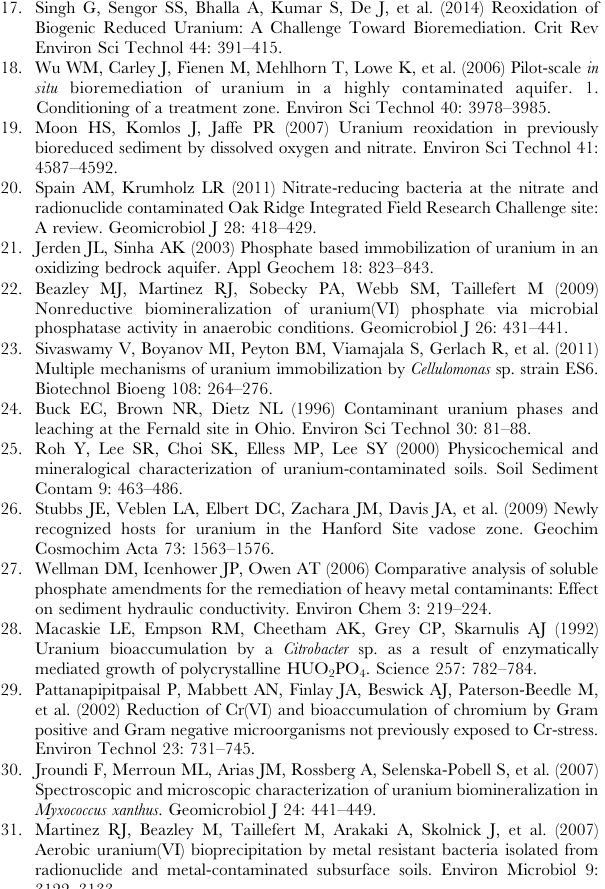
Figure S1 Venn diagram of OTUs enriched in multiple treatments. (A) Archaeal and (B) bacterial OTUs detected in one or more of the organophosphate-amended treatments. Only OTUs that had a 2-fold or greater increase in fluorescence for each respective treatment were used for comparisons. Figure S2 Thermodynamic modeling of P and Ca in the absence of U(VI) as a function of pH. ORFRC Area 2 groundwater concentrations of dissolved ions (GW-836 monitoring well), U(VI)= 4.5 m M, and Ca 2 + = 4.85 mM were used to model the distribution of PO 43 2 species with (A) PO 43 2 = 500 m M, (B)